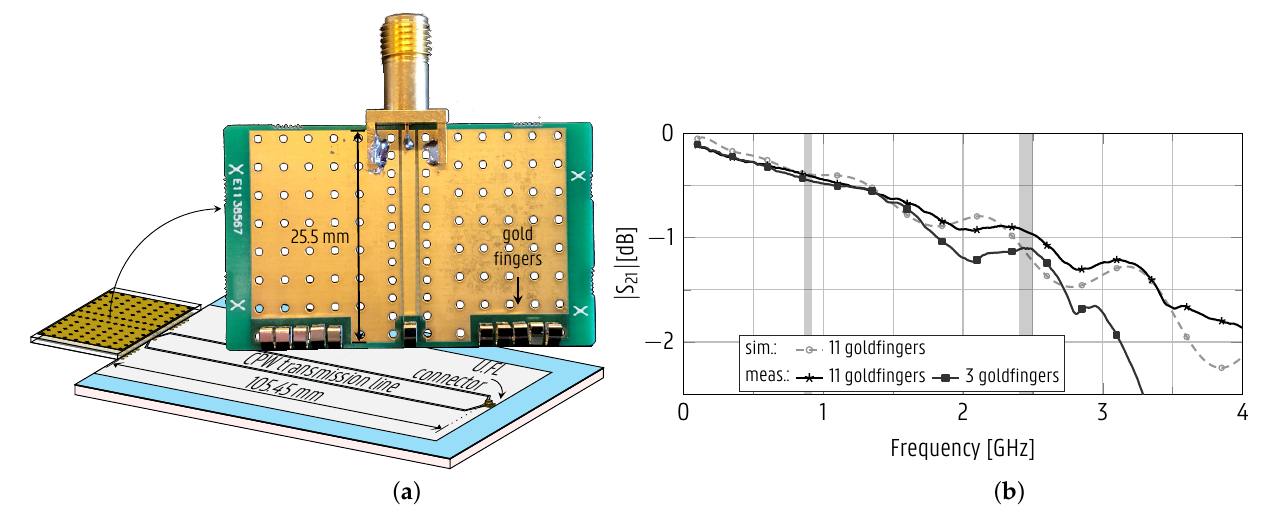
Figure 5. Interposer PCB used to connect to the antennas. ( a ) The measurement setup to characterize the insertion loss of the interposer PCB contacting a CPW line and ( b ) the corresponding simulated and measured magnitude of the transmission coefficient. Prototypes with 3 and 11 gold fingers were fabricated and